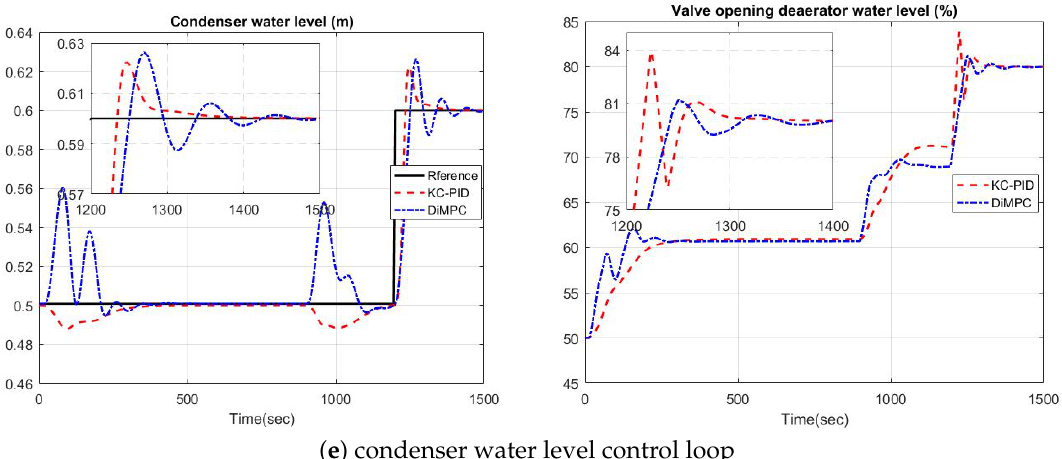
Figure 9. Outputs of the steam/water loop with KC based PID controller and MPC (The outputs are listed on the left, and the inputs are listed on the